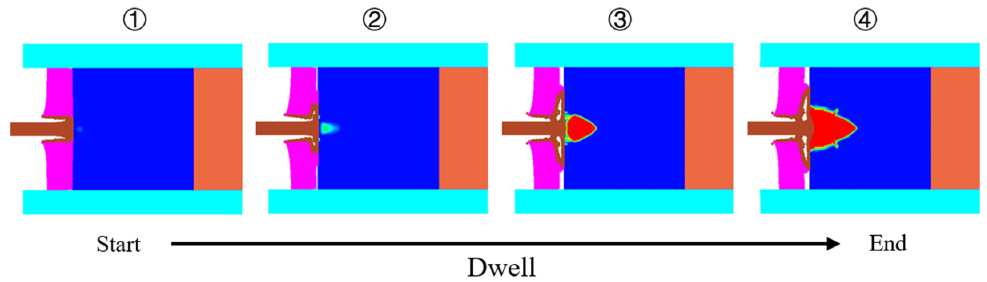
Figure 7. Illustration of the dwell process at the impact velocity of 1200 m/s (4 mm thick cover plate with the free-mode).